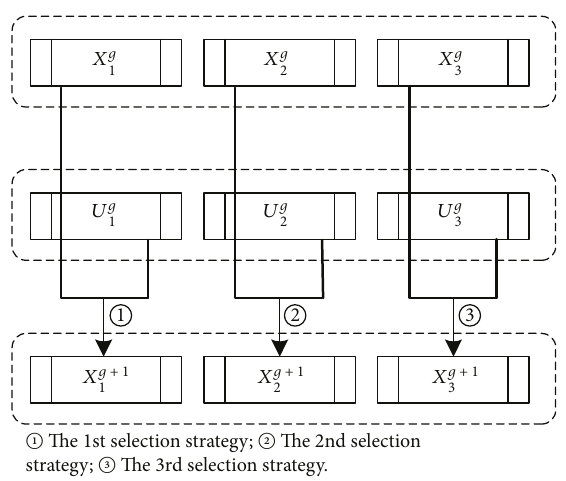
Figure 3: The main selection process using